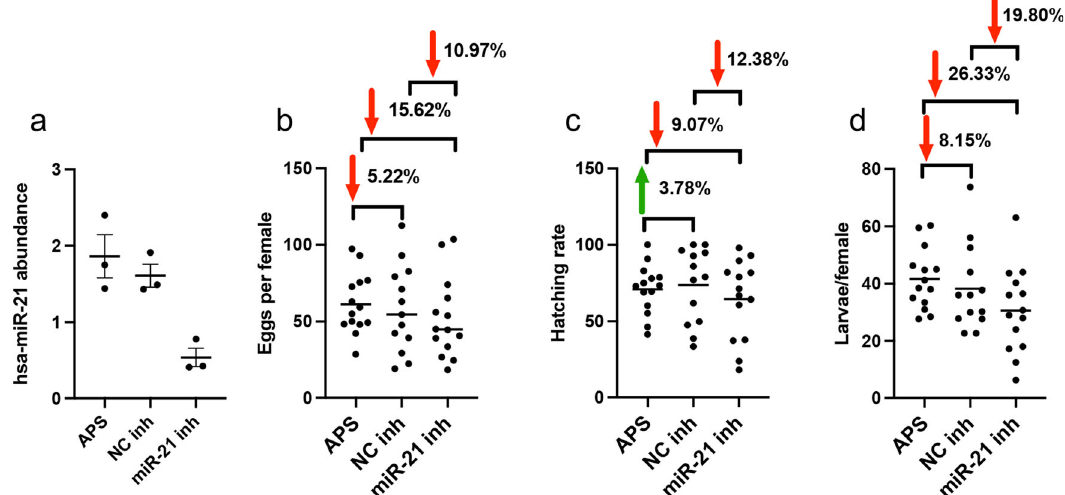
Fig. 7 Inhibition of hsa-miR-21-5p leads to a reduction in the number of mosquito progeny. Four-day-old Ae. aegypti females were injected with hsa-miR- 21-5p inhibitor, negative control inhibitor or APS buffer only. Four days after injection, mosquitoes were fed on a human volunteer. Between two to seven mosquitoes per replicate were pooled into a cage. Subsequently, the number of eggs deposited, eggs hatch rate, and the number of larval progenies were determined per cage and averaged per female. a A group of mosquitoes was collected 12 h after feeding to con fi rm inhibition of hsa-miR-21-5p. RNA was extracted from the mosquitoes, and the detection of hsa-miR-21-5p was carried out with RT-qPCR. Ae. aegypti U6 non-coding small nuclear RNA was used as reference. Error bars represent standard error of the mean (SEM) in three biological replicates. b The number of eggs deposited per female. Percent reduction (red arrow) in the number of deposited eggs is shown for each treatment. c Larva hatch rates are shown for each treatment. Percent reduction (red arrow) or increase (green arrow) in egg hatching is shown for each treatment. d The total number of larvae produced per female. Percent reduction (red arrow) in the number of larvae per female is shown for each treatment. The experiment was repeated fi ve times independently with similar trends obtained. Each point represents the average of each pool. Upon testing, data in b – d showed normal distribution. One-way ANOVA with Tukey ’ s post-hoc multiple comparisons were used for data